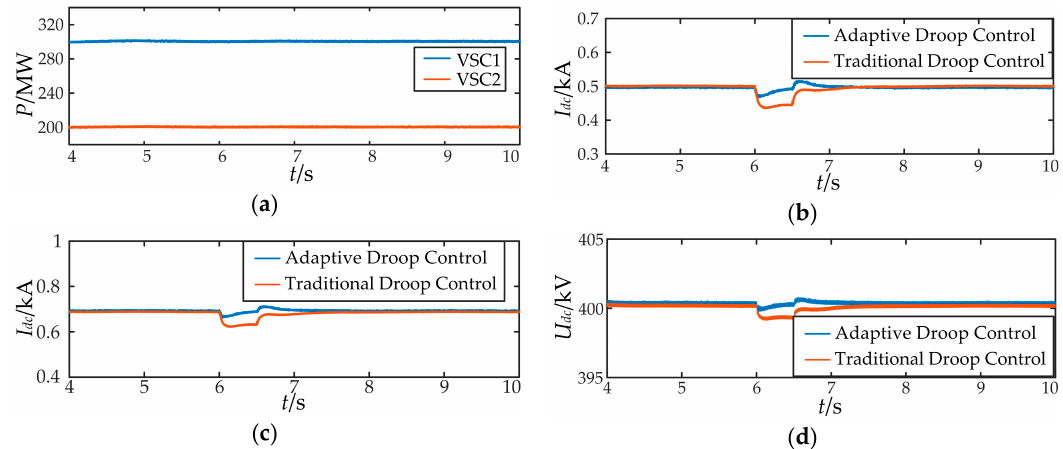
Figure 17. Simulation waveforms of a three-phase short circuit fault in the AC grid on the VSC1 side: ( a ) Active power of VSC1 and VSC2; ( b ) DC current of LCC3; ( c ) DC current of LCC4; ( d ) DC voltage.